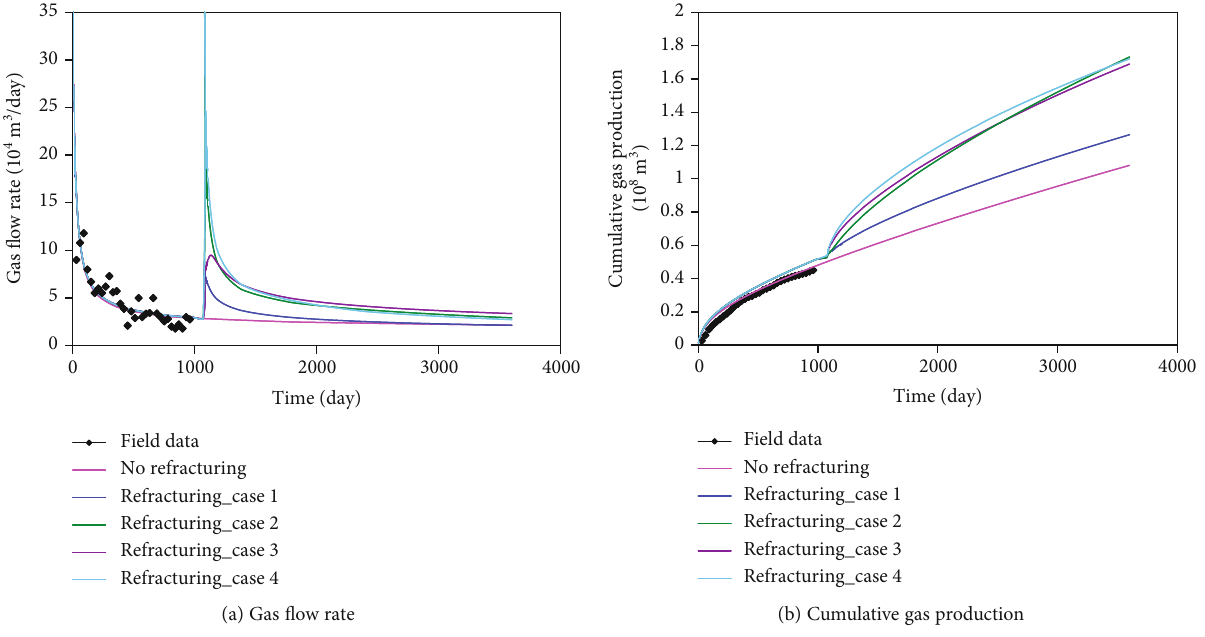
Figure 11: Daily production and cumulative production based on di ff erent refracturing